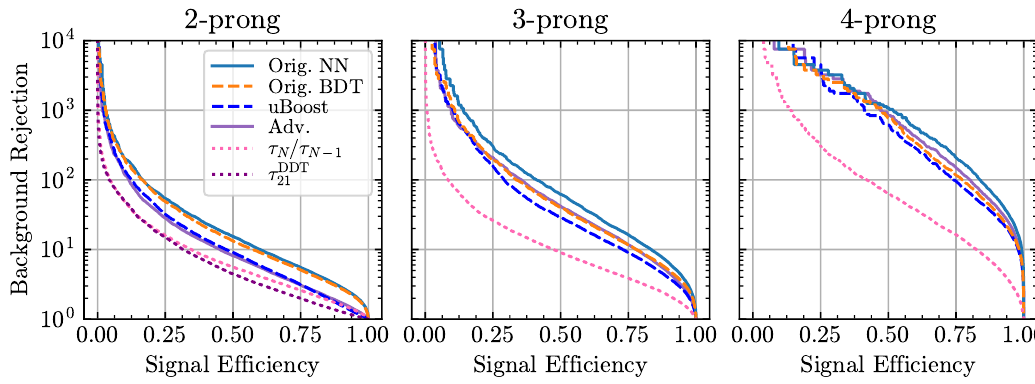
Figure 11: ROC curves for the 2-, 3-, and 4-prong signal jets versus QCD background for the methods which augment the training method to decorrelate the jet mass. The solid, dashed, and dotted curves show results for neural networks, boosted decision trees, and single variable analysis, respectively. The light blue curves are for the tradi- tional method benchmarks. The purple and dark-blue lines denote the adversarially trained network and uBoost decision tree. For the 3- and 4-prong cases, uBoost can- not classify as well as the adversarially trained neural networks, but still does